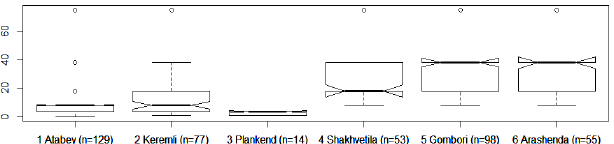
Fig. 10 . Box-and-whisker plots of “Sum of grazing indicator species” on 100 m² in percent.